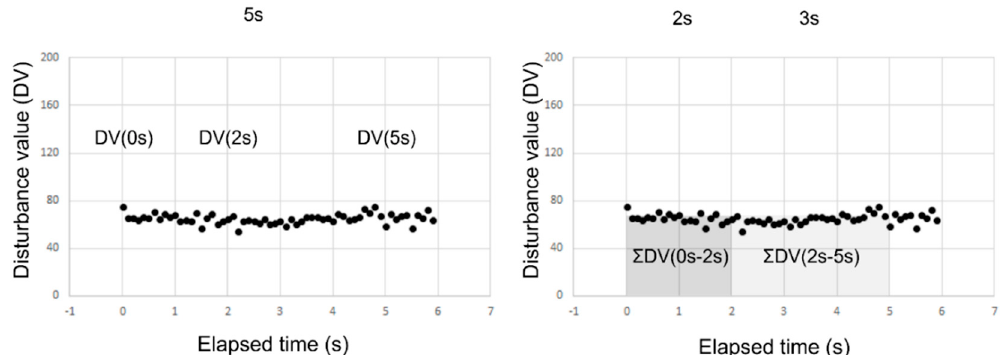
Figure 3. Parameters related to DV. The VK instrument provides a graph presenting time-dependent change of DVs from the time point immediately after eye opening (i.e., time = 0 s (s)). Seven parameters associated with the DVs were then obtained from the graph, including DV immediately after eye opening (DV(0 s)) and at 2 s and 5 s after eye opening (DV(2 s) and DV(5 s), respectively) (shown in the left graph), the rate of change of DV from 0 s to 2 s and from 2 s to 5 s after eye opening, defined by the equations (DV(2 s) − DV(0 s))/2 and (DV(5 s) − DV(2 s))/3, respectively, and the sum of DV from 0 s to 2 s and from 2 s to 5 s after eye opening, Σ DV(0 s–2 s) and Σ DV(2 s–5 s), respectively (shown in the right graph). DV was calculated every 0.1 s.